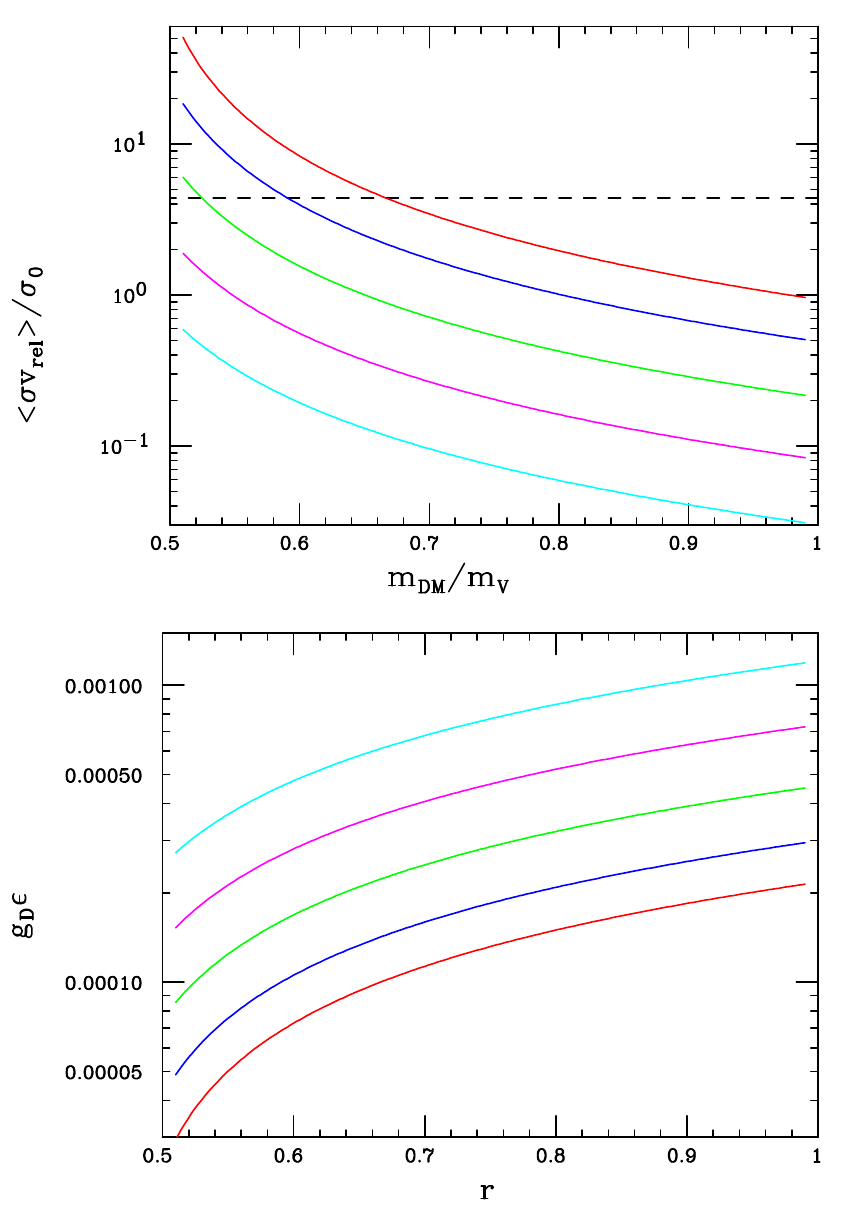
Figure 4 . (Top) DM co-annihilation cross section in units of σ 0 assuming that g D (cid:15) = 10 − 4 and m V = 100 MeV for purposes of demonstration as a function of r = m DM /m V . From top to bottom the curves correspond to the choices of δ = 0 . 05 , 0 . 10 , 0 . 15 , 0 . 20 and 0 . 25 , respectively. The dashed line represents the approximate cross section needed to obtain the observed relic density. Results for other values of the parameters can be obtained by simple rescaling using the results in the text. (Bottom) Values of g D (cid:15) required to obtain the observed relic density employing the same parameter values with curves labelled in reverse order from the top